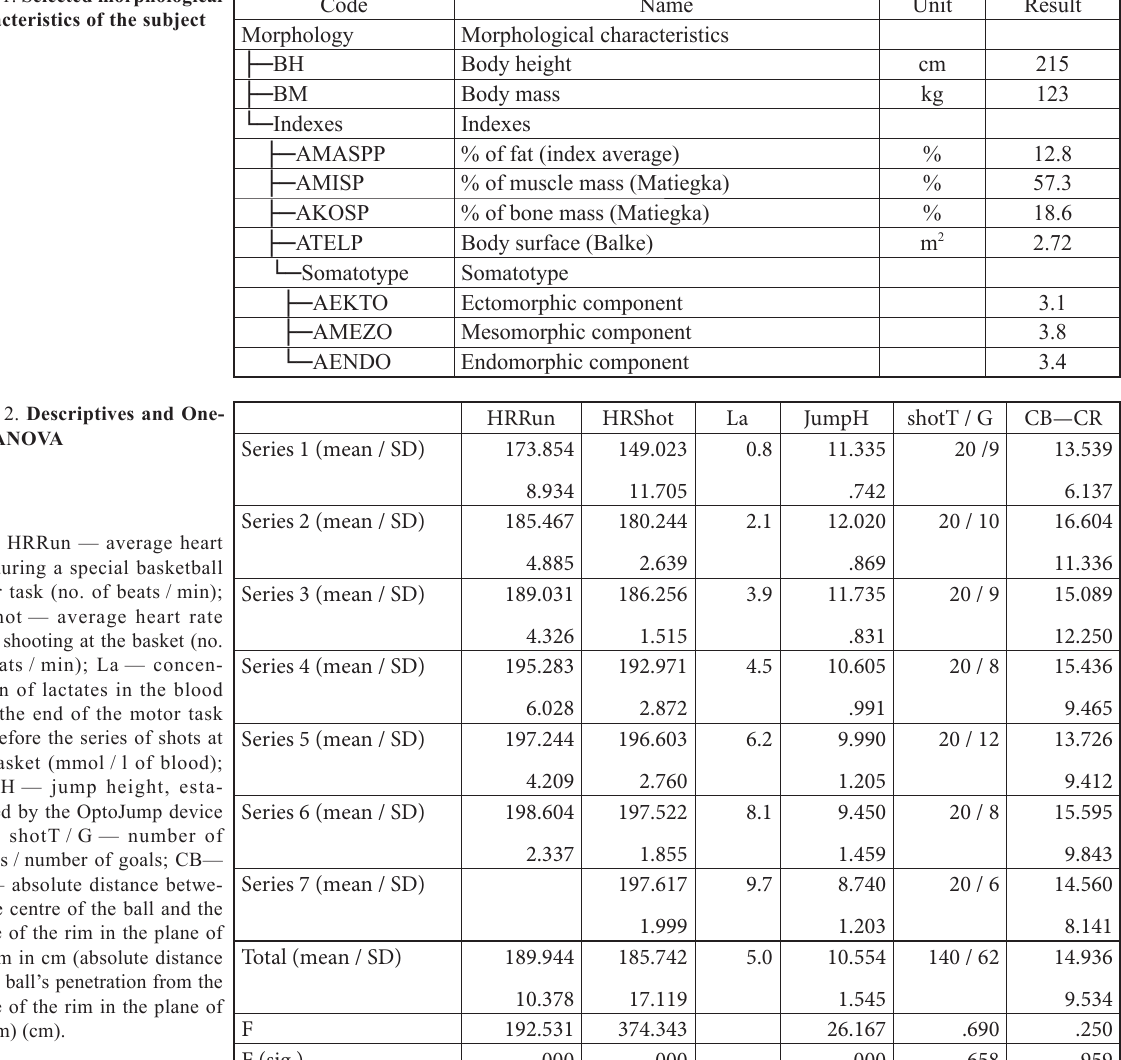
Table 1. Selected morphological characteristics of the subject